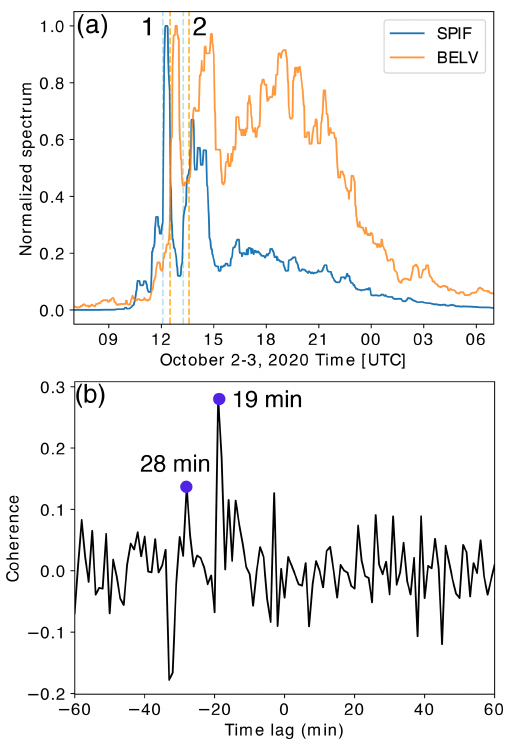
Figure B9. (a) Normalized seismic power recorded at the SPIF and the BELV stations smoothed over a 30min moving time average. Arrivals times of peaks 1 and 2 are marked by dashed lines. (b) Normalized cross-correlation (coherence) between the normalized seismic power shown in (a) .